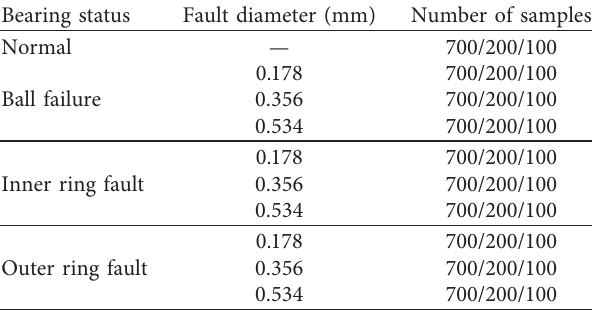
Table 3: Bearing test data set.